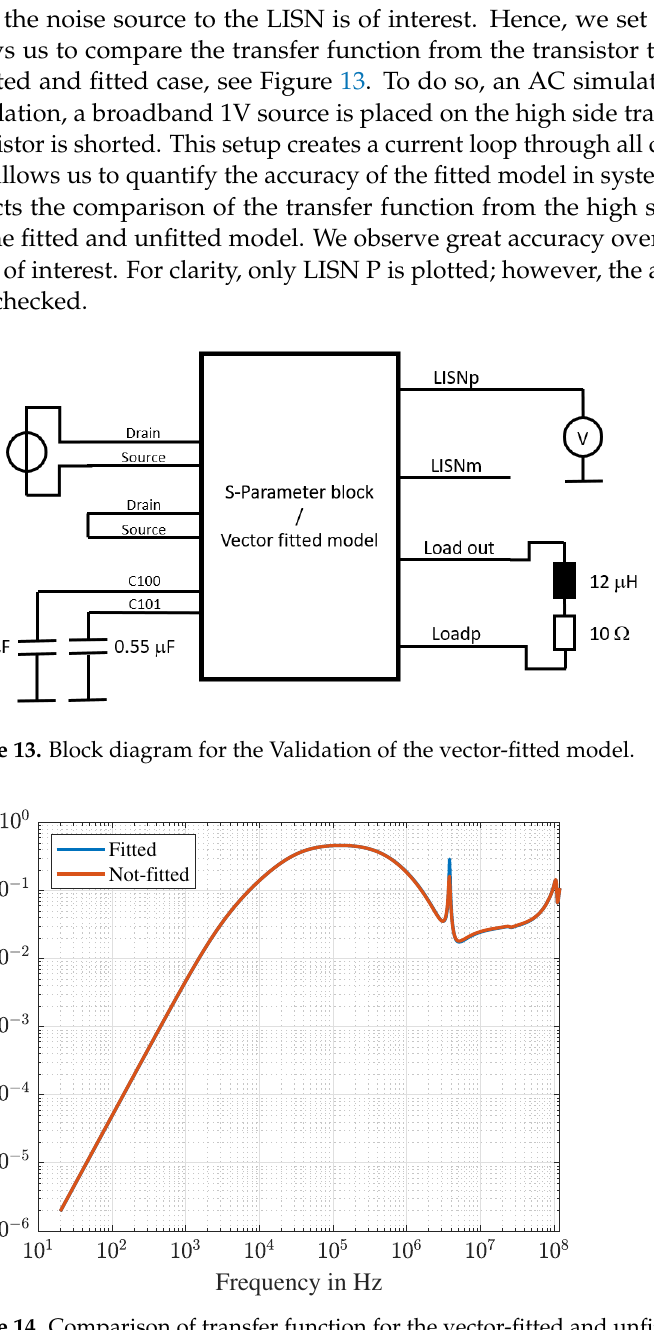
Figure 14. Comparison of transfer function for the vector-fitted and unfitted (S-Parameter)